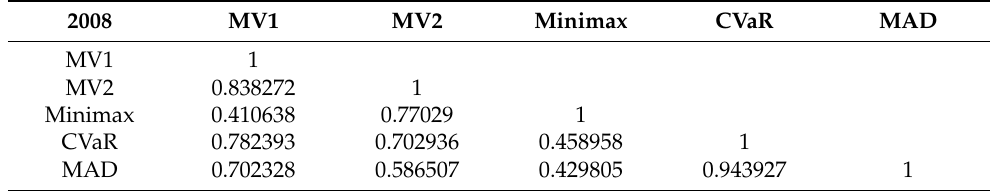
Table A5. Correlation coefficients among portfolio values based on “buy and hold” strategy in 2008.